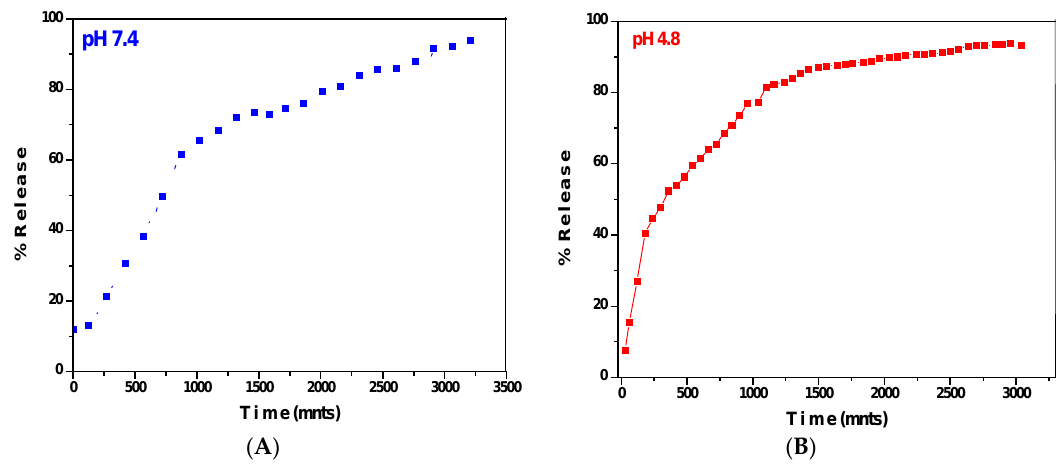
Figure 7. In vitro release profile of PEITC from the nanocomposite GO-PEITC in human body simulated PBS solution of pH 7.4 ( A ) and pH 4.8 ( B ) in vitro cytotoxicity analysis.